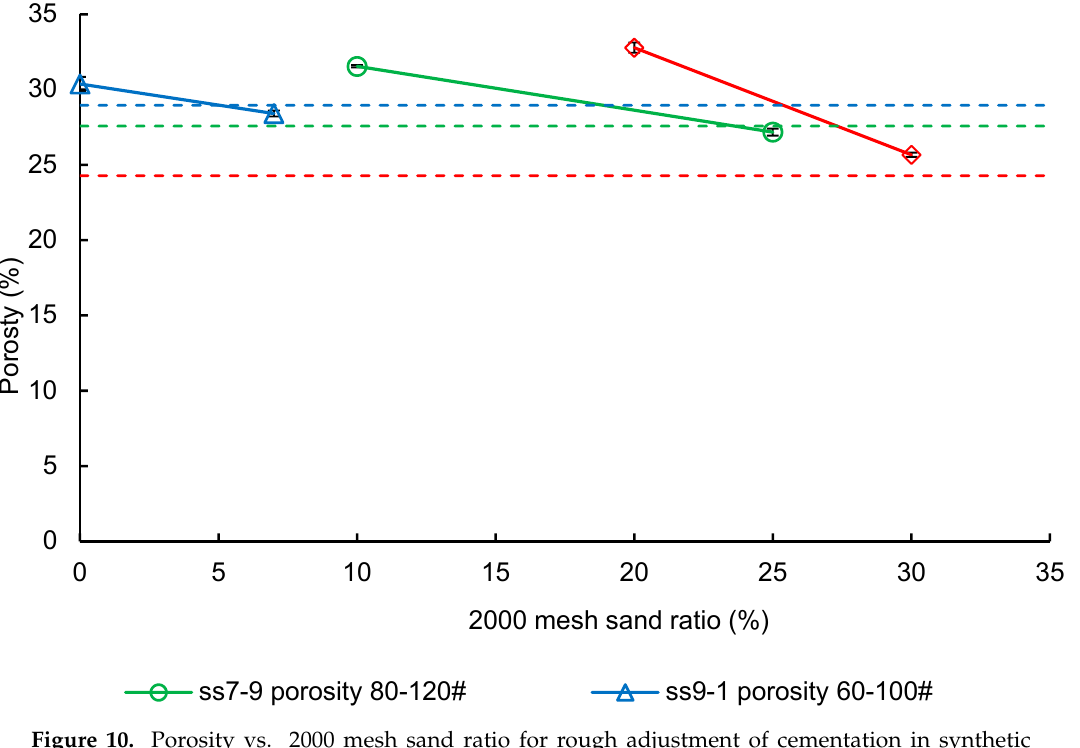
Figure 9. Permeability and porosity vs. pressure. Permeability curve is plotted with Δ , and porosity curve is plo tt ed with ● .